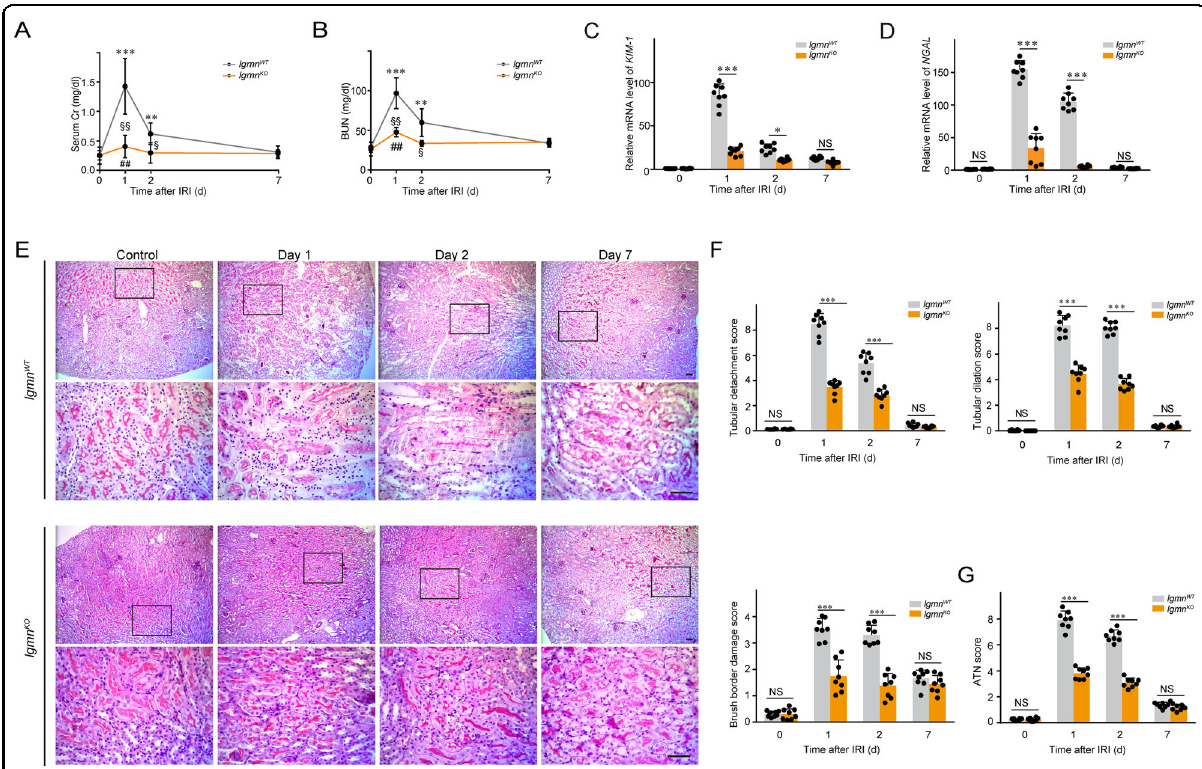
Fig. 1 Legumain de fi ciency attenuates acute tubular injury in a mouse model of IRI. Lgmn WT and lgmn KO mice were randomized to 40 min of bilateral ischemia ( n = 8). Kidney and serum samples were collected before and at day 1, 2, and 7 after IRI. A , B Renal functions assessed by serum creatinine (Cr) and BUN levels at the corresponding time points after IRI. * P < 0.05, ** P < 0.01, *** P < 0.001 versus lgmn WT control; ♯ P < 0.05, ♯♯ P < 0.01 versus lgmn KO control; § P < 0.05, §§ P < 0.01 versus lgmn WT after IRI at the corresponding time point. C , D Quanti fi cation of kidney KIM-1 and NGAL mRNA levels by qPCR. E Each pair of images includes a representative PAS-stained histologic photomicrograph of the kidney (top) from lgmn WT and lgmn KO mice on the indicated days after IRI and higher-magni fi cation photomicrographs of the renal cortex (bottom; corresponding to the boxed area). Scale bar, 50 μ m. F Quanti fi cation of histological renal damage. Tubular detachment, tubular dilation, and brush border damage were scored by the percentage area. G Histological ATN score. All data are expressed as the mean ± SD, * P < 0.05, *** P < 0.001; two-way